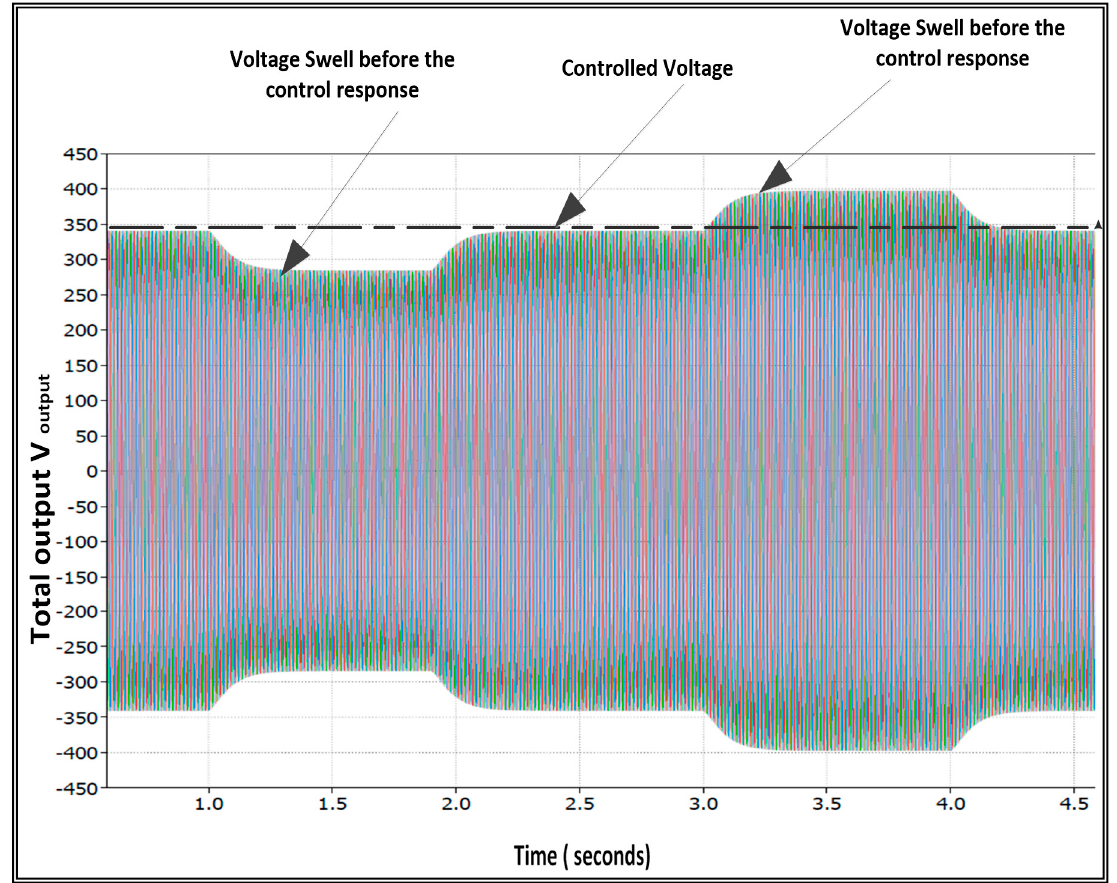
Figure 18. Voltage fluctuation regulation.